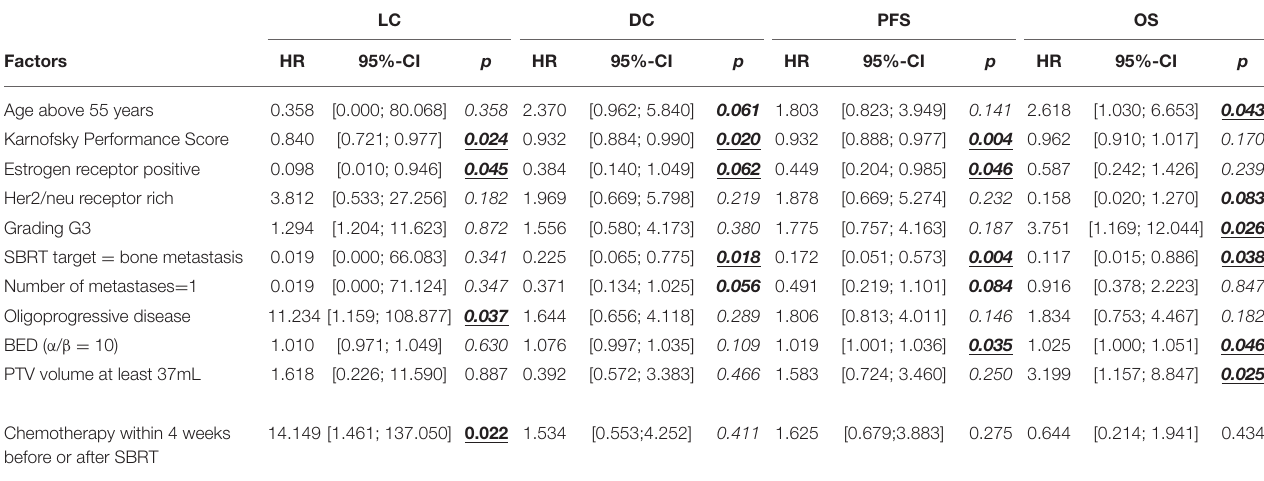
TABLE 4 | Univariate analysis of prognostic factors influencing LC, DC, PFS, and OS. LC